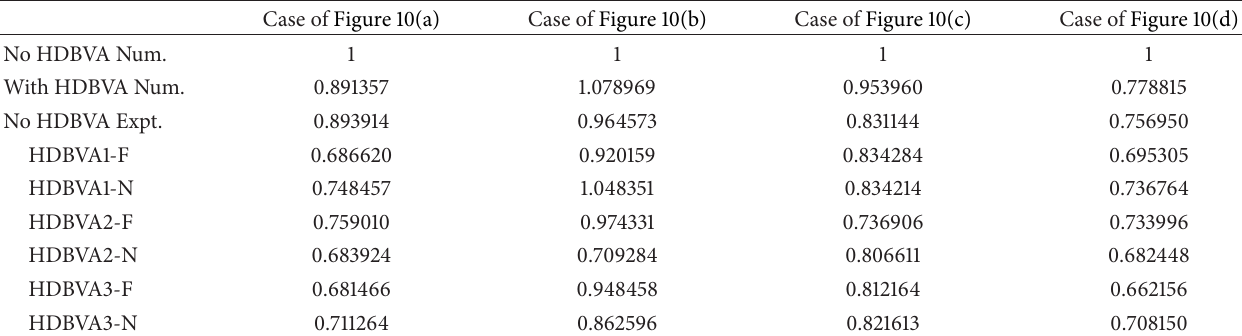
Table 4: Damping effects of groove and slider combinations (away from natural frequency and